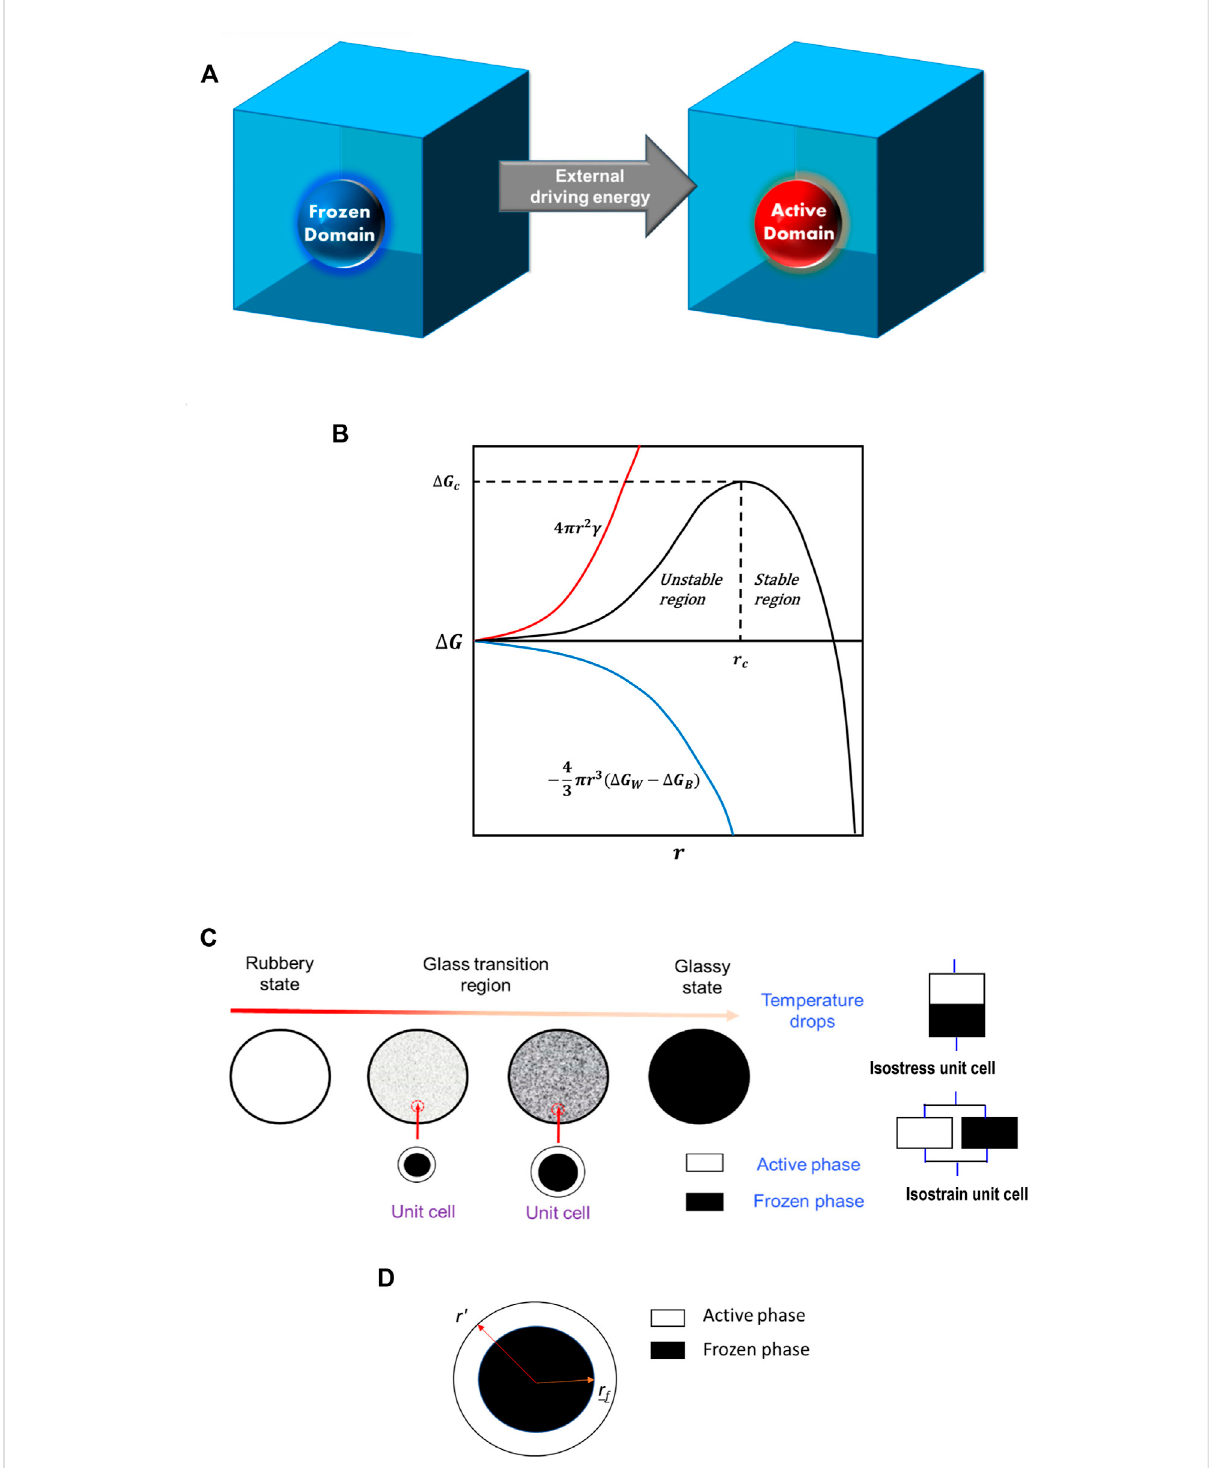
FIGURE 3 (A) Schematic illustration of how a frozen domain (blue sphere) in the frozen phase matrix (blue cube) evolves into an active domain (red sphere). (B) Free-energychangecausedbytheappearanceoftheactivedomainasafunctionofdomainradius r . Δ G c istheenergychangewhenthe domain size reaches the critical value r c . The domains with r > r c will be stabilized in the active phase (and may grow in fi nitely upon perturbation), while the domains with r < r c will revert to the frozen phase upon fl uctuations. (Reproduced with permission from International Journal of Plasticity, 80:168-186, (2016). Copyright 2016 Elsevier.) (C) Schematic of transition from the active phase to frozen phase as the temperature drops (left)andisostressandisostrainunitcells(right),whicharecurrentlyusedintheliterature. (D) Proposedtwo-phaseunitcell,whichisneitherisostress nor isostrain (Reproduced with permission from Smart Materials and Structures, 28: 095030 (2019). Copyright 2019